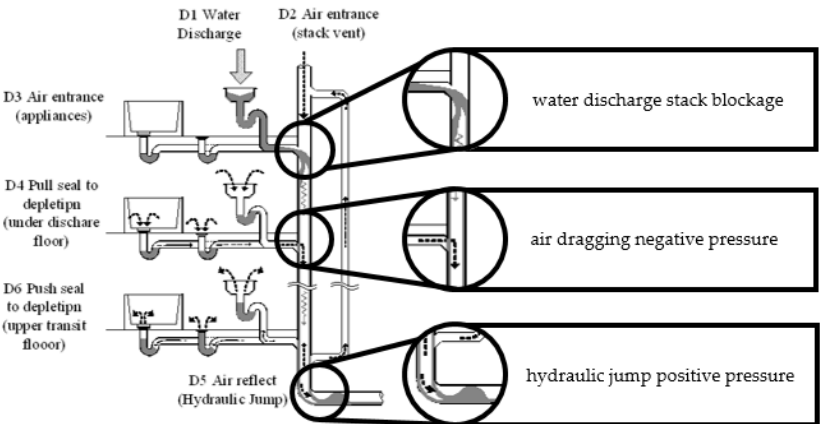
Figure 1. Mechanism of double stack pipe drainage system design in residential buildings.